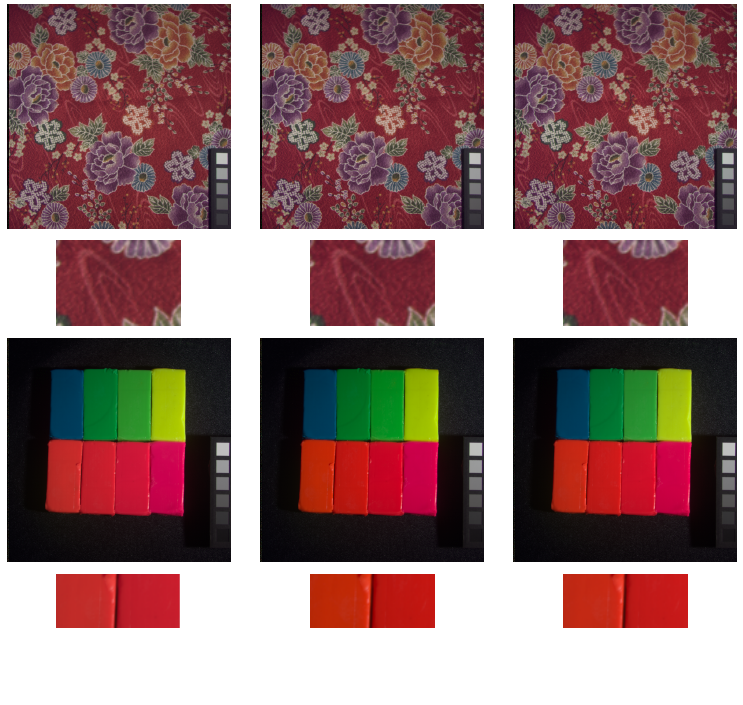
Figure 14. Qualitative evaluation of the approach versus matrix sampling. Top two rows, minimizing the S-CIELAB measure: full image ( first row ) and detail ( second row ). Last two rows, minimizing the CID measure: full image ( third row ) and detail ( last row ). For each column, the images are: matrix sampling ( left ), original ( center ) and spherical sampling (right ).